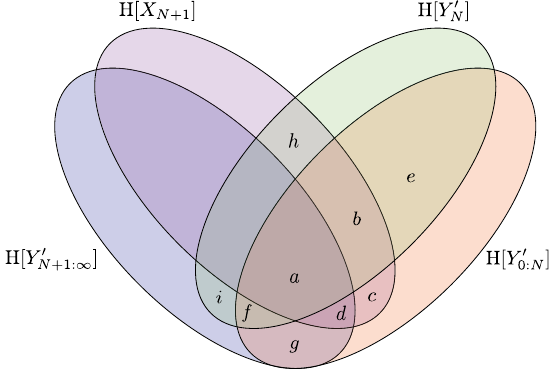
FIG. 9. Information shared between the output past Y 0 0 ∶ output Y 0 , next ratchet state X N excluding the next input. Key information atoms are